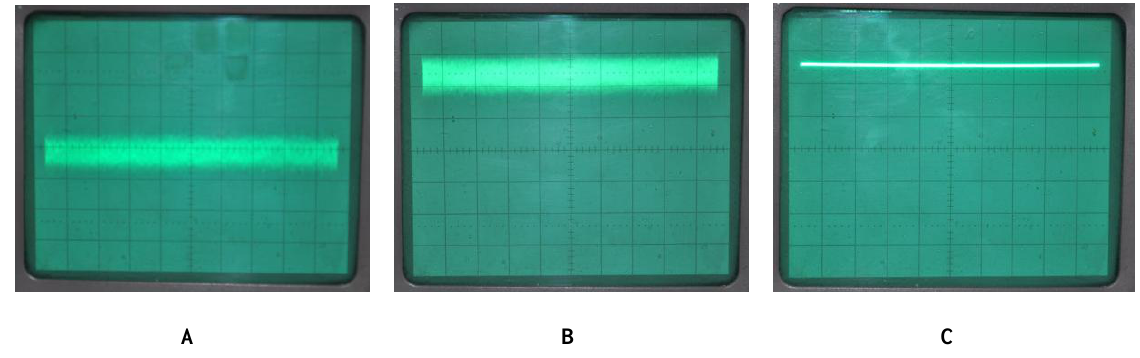
FIGURE 5. Electronic signal output: (A) from the sensor (direct voltage: 250 mV / noise: 10 mV p-p [peak to peak]); (B) after amplification (direct voltage: 2.5 V / noise: 100 mV p-p); (C) after filtering (direct voltage: 2.5 V / noise: <5 mV p-p).